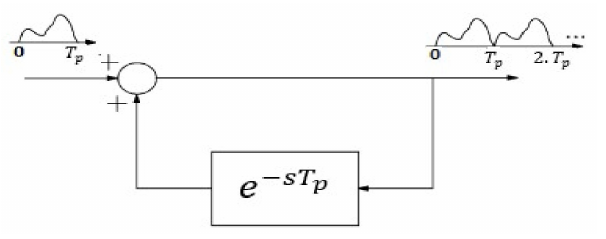
Figure 9. Control law of